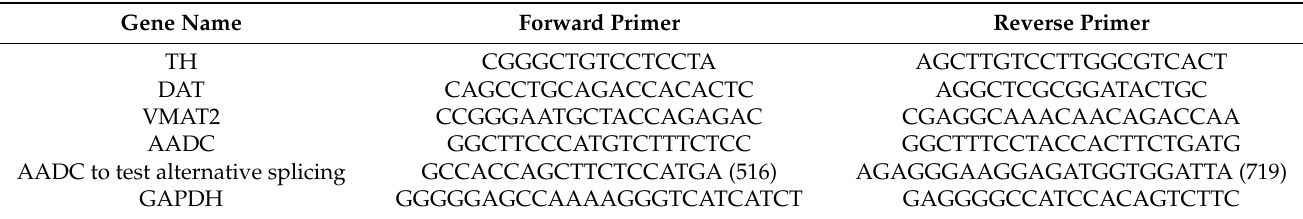
Table 3. The nucleotide primers used in this